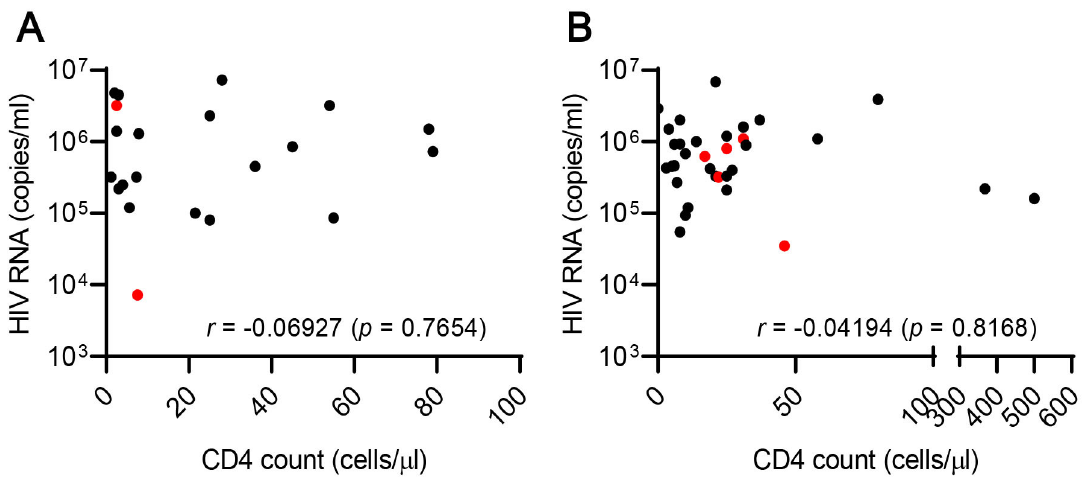
Figure2. CorrelationsofCD4countandviralloadinpatientswithAIDS( A )andAIDS / TB( B ).Redcircles Figure 2. Correlations of CD4 count and viral load in patients with AIDS ( A ) and AIDS/TB ( B ). Red represent deceased patients. circles represent deceased patients.